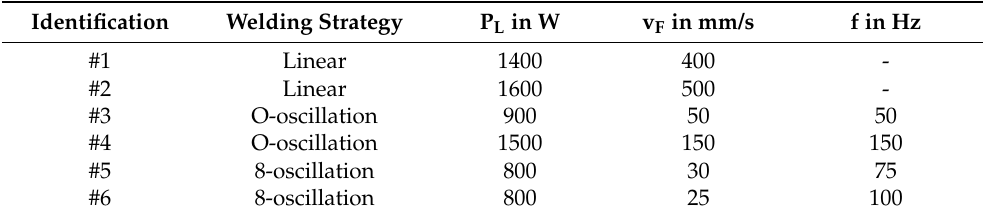
Table 4. Process parameters developed from the preliminary study for different overlap welding strategies from copper to aluminum.